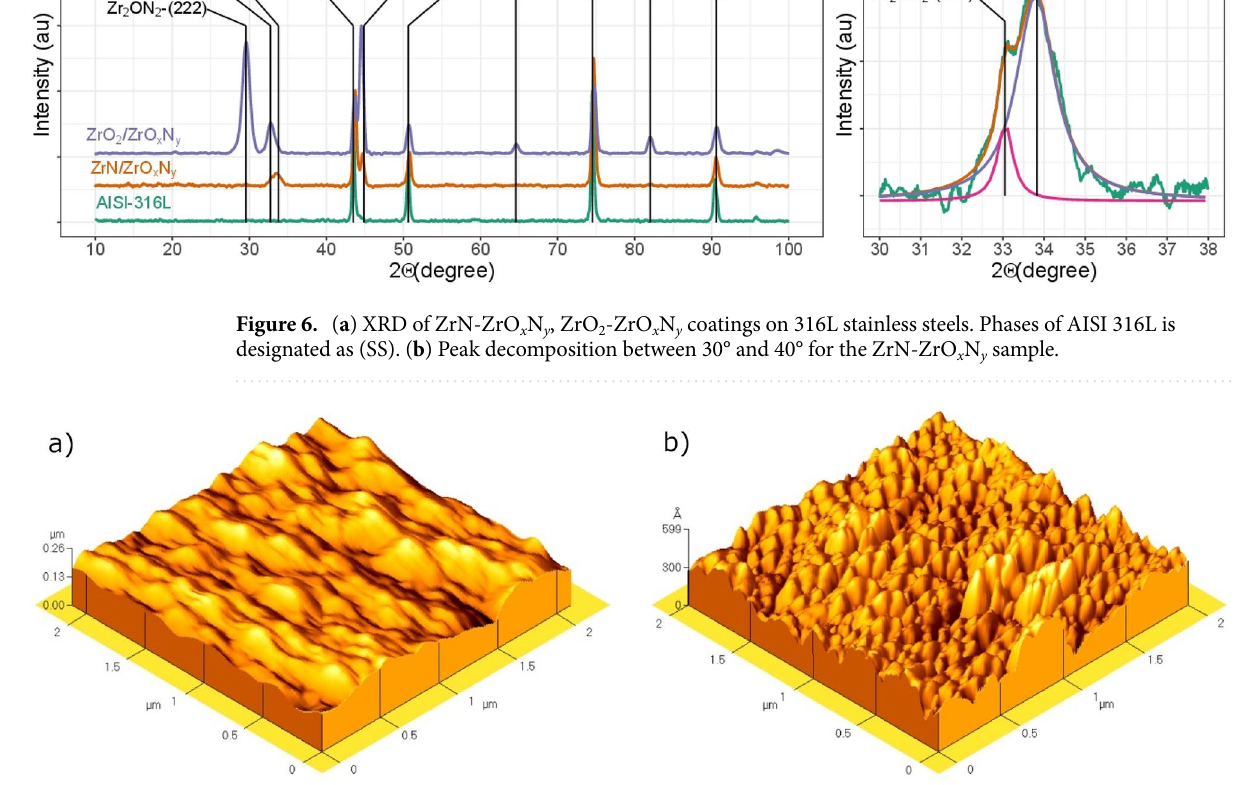
Figure 7. AFM micrograph image of the ZrO x N y film. ( a ) ZrO 2 -ZrO x N y , ( b ) ZrN-ZrO x N y deposited on 316L stainless steel. ( a ) XRD of ZrN-ZrO x N y , ZrO 2 -ZrO x N y coatings on 316L stainless steels. Roughness Grain Sample